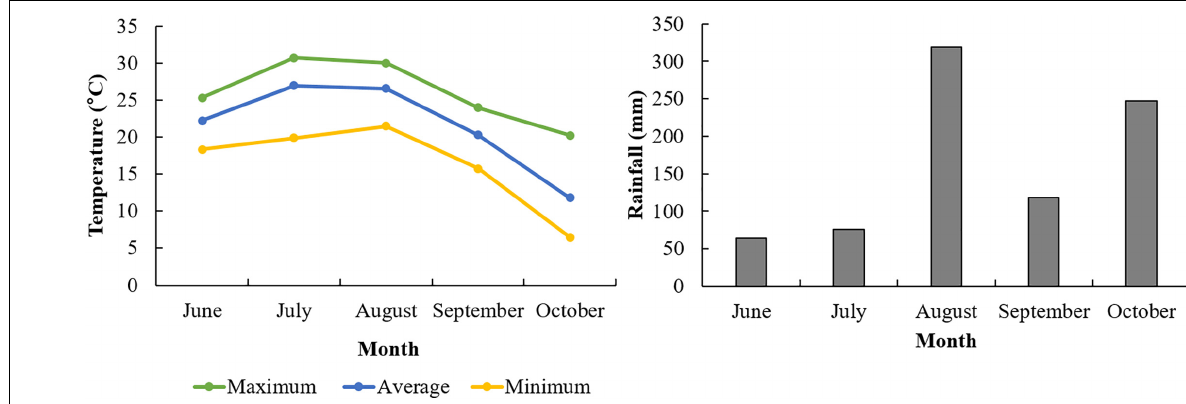
FIGURE 1 | Weather condition of experimental field in 2018.